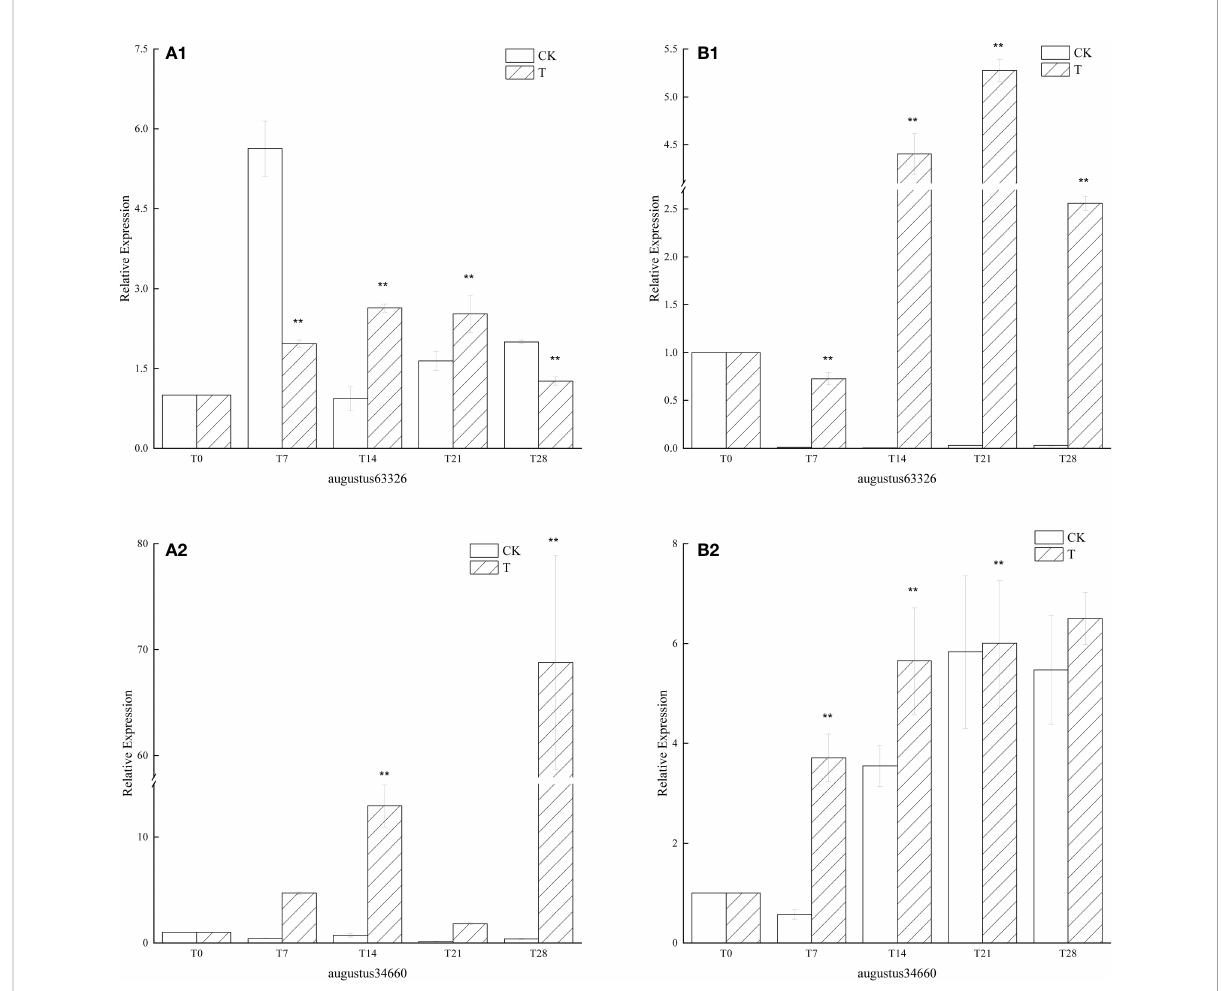
FIGURE 4 Relative expression of similar genes augustus63326 and augustus34660 of FT in the leaves of plants with different treatments in L. chinense var. rubrum. ‘ (A) ’ represents the relative expression of similar genes of FT in leaves of ‘ Xiangnong Xiangyun ’ under different treatments. ‘ (B) ’ represents the relative expression of similar genes of FT in leaves of ‘ Hei Zhenzhu ’ under different treatments. ‘ T ’ represents the low- temperature treatment group and ‘ CK ’ represents the blank control group treated at 25°C. ** extremely signi fi cant